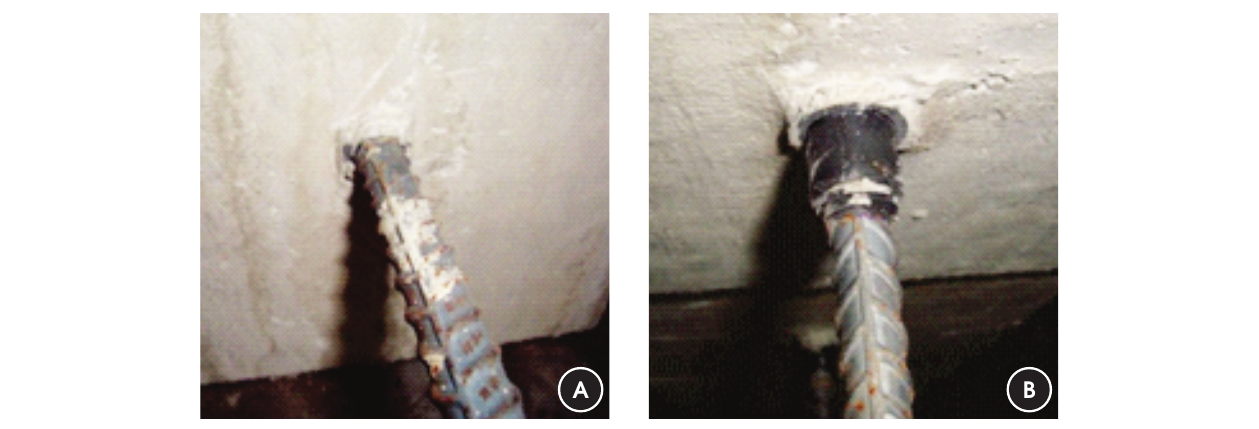
( t ) was calculated based on the maximum pullout force. Figure bmáx 5 shows the metal mold on a vibrating table and the specimens for the POT method tests.